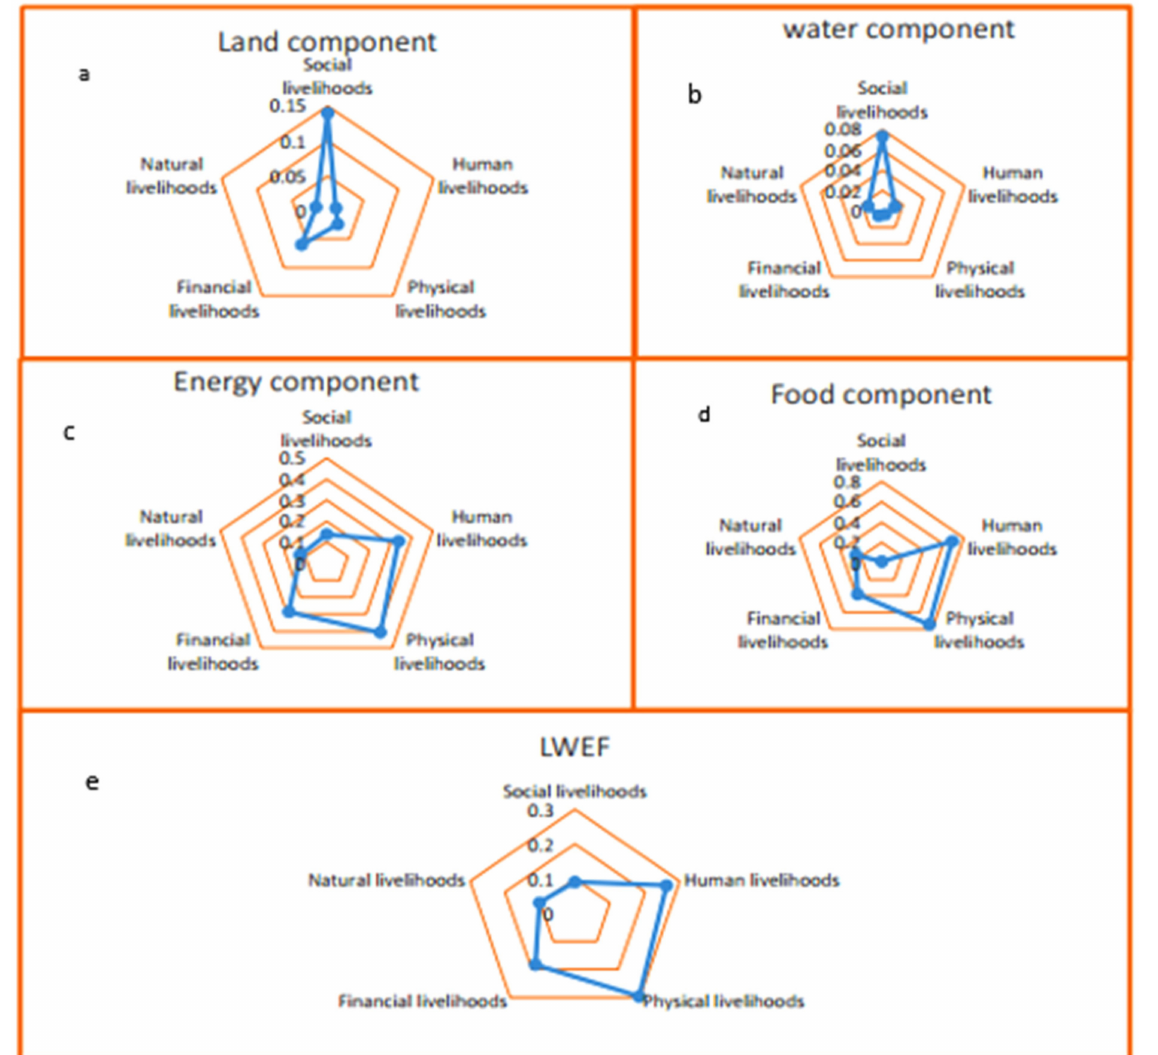
Figure 3. The spider web showing the weight of change of LWEF nexus resources indicators on livelihood